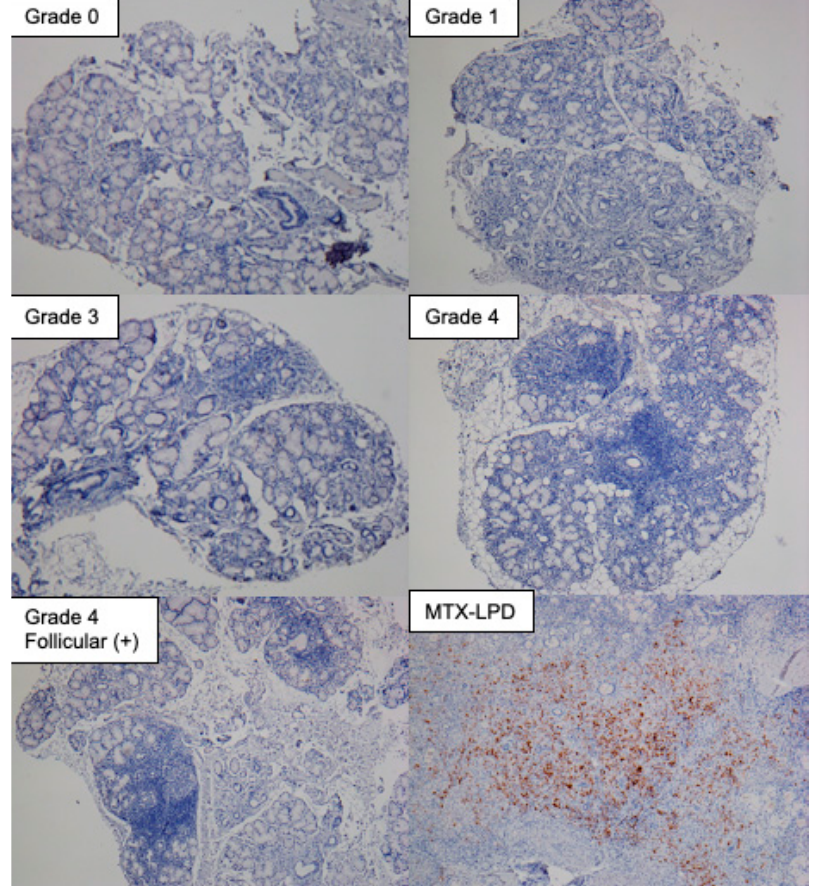
Figure 4. EBNA expression in minor salivary gland tissues from SS and MTX-LPD patients. Samples graded 0 to 4 according to Greenspan grade [40,41] were used for this analysis. Grade 0 = the absence of lymphocytes and plasma cells per 4 mm 2 in labial salivary glands (LSGs), Grade 1 = mild infiltration of lymphocytes and plasma cells per 4 mm 2 in LSGs, Grade 2 = a moderate infiltration or less than one focus per 4 mm 2 in LSGs, Grade 3 = a single focus per 4 mm 2 in LSGs, and Grade 4 = more than one focus per 4 mm 2 in LSGs. The stained sample shown was from a gingival mucosa biopsy in a patient with MTX-LPD. Immunohistochemical analysis, performed using paraffin-embedded sections, used FLEX monoclonal mouse anti-EBV, LMP antibody (Clone: CS.1–4, DAKO) as the primary antibody, and SignalStain Boost IHC (horseradish peroxidase: HRP, mouse) (Cell Signaling) as the secondary antibody. EBNA expression was visualized by 3,3-diaminobensidine (DAB) reaction, and counterstaining was performed by hematoxylin. The image is unpublished.